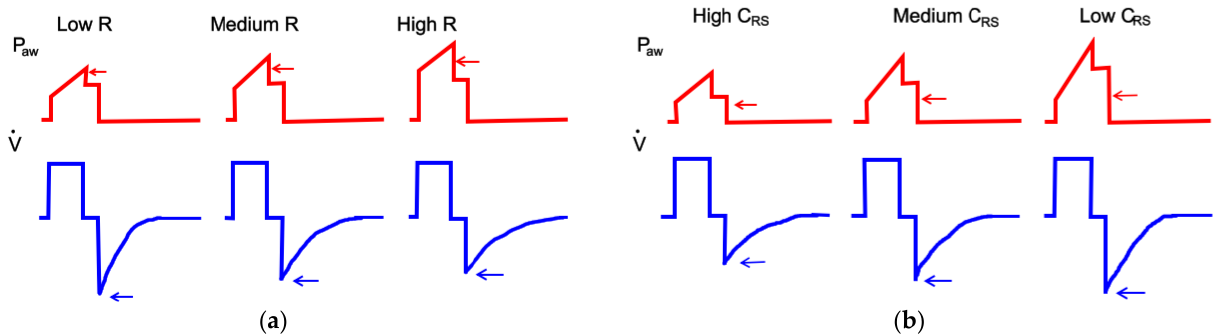
Figure 4. Effect of the increase in resistance airway ( a ) and decrease in lung compliance ( b ) during VC − CMV mode, adapted from [45].